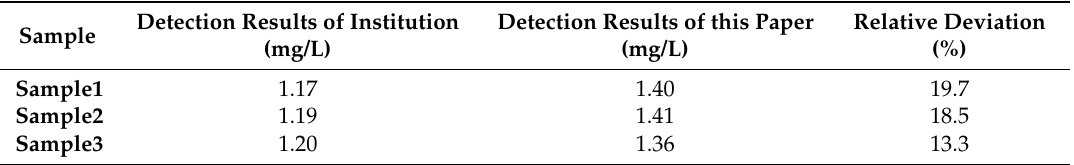
Table 2. The results of the actual water sample